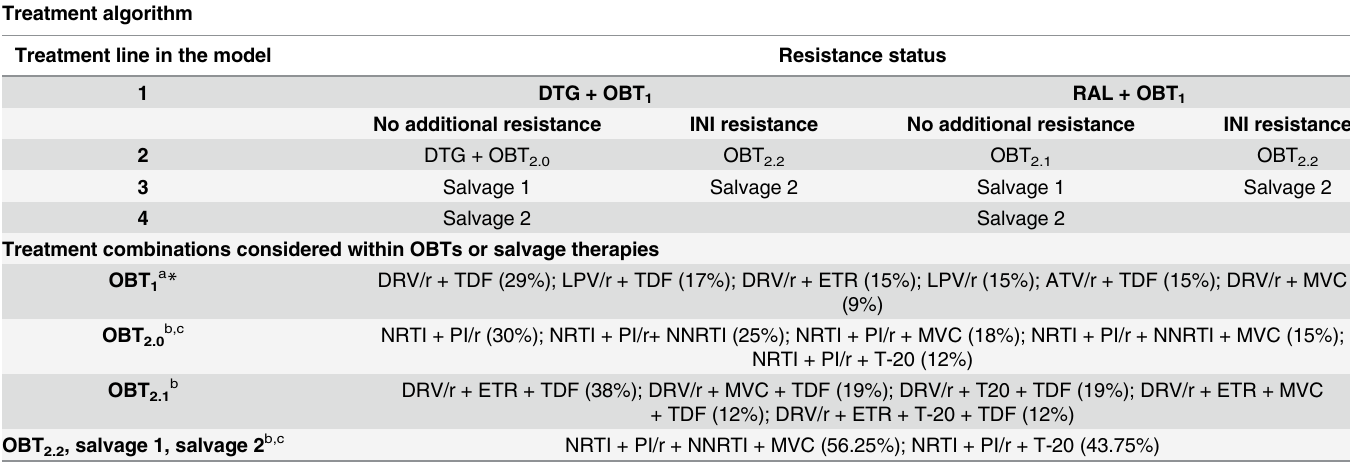
Table 1. Treatment algorithm considered in HIV patients. Treatment